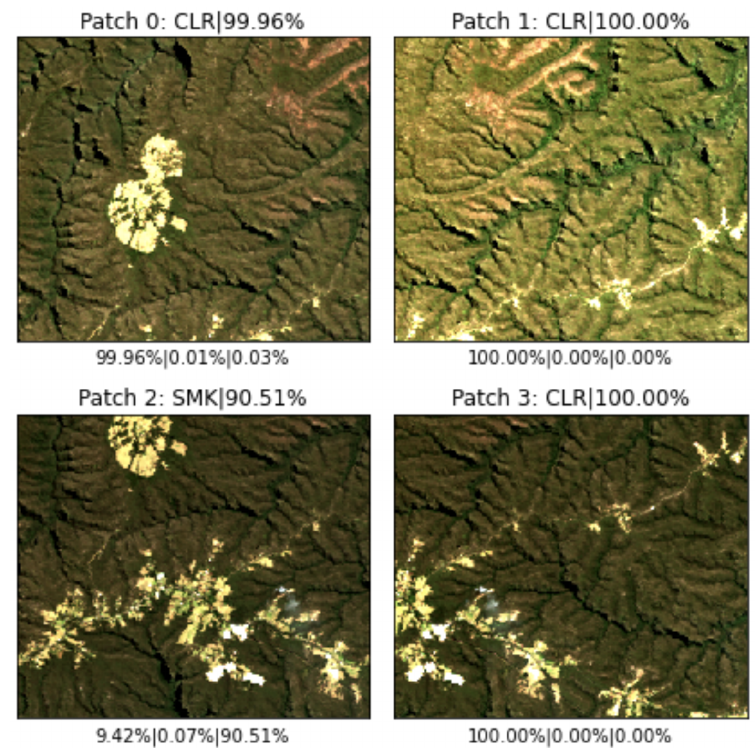
Figure 12. Prediction results of scene (c) in Figure 9.